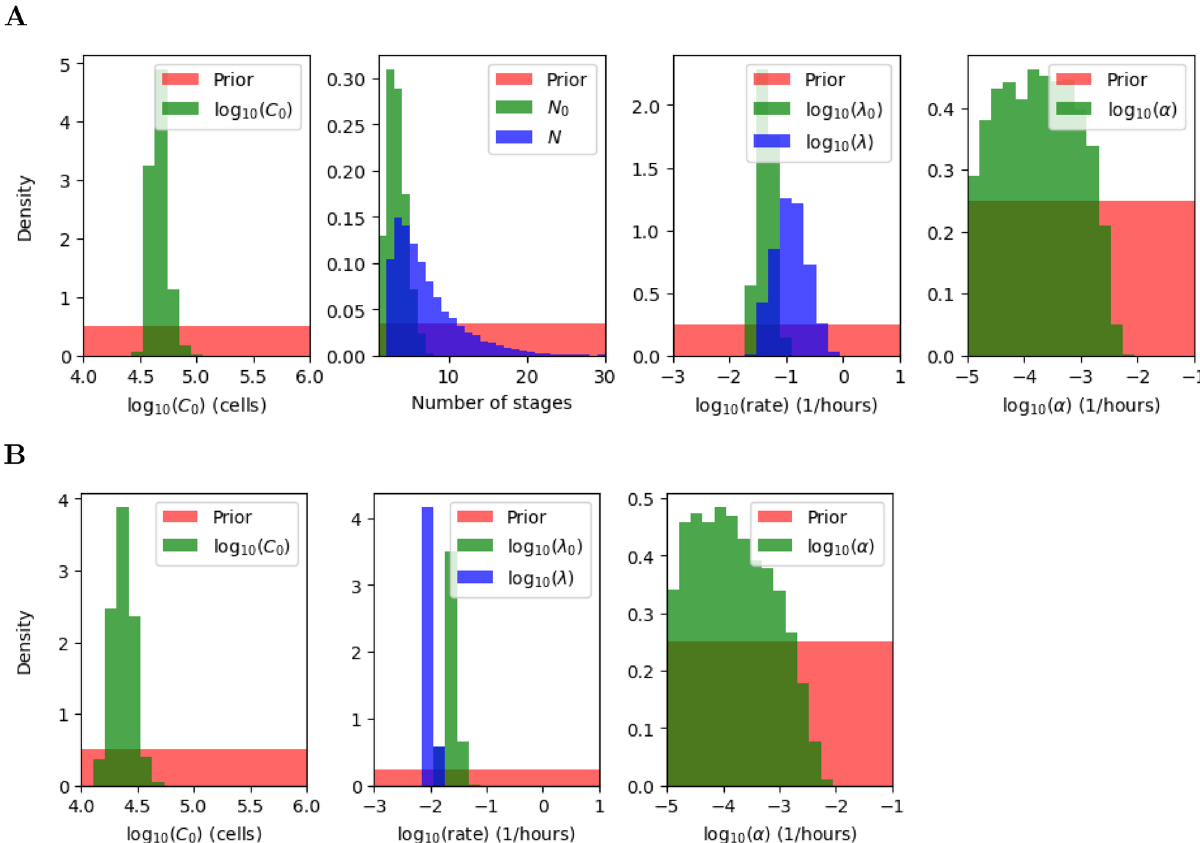
Figure 8. Posterior distributions (green and blue) for the parameters in the multi-stage ( A ) and exponential ( B ) model for OT-I T cells. In the exponential model, the number of stages for all generations is equal to 1, i.e., 1 . Prior distributions are shown in N 0 N = =